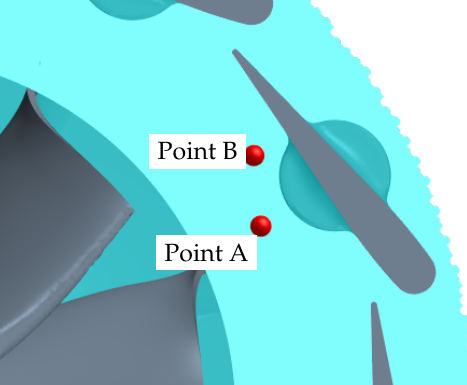
Figure 4. Selected points to evaluate the Mach number. Point A (at the middle of the stator vaneless space) and Point B (at a radial distance of R = 26.08 mm).